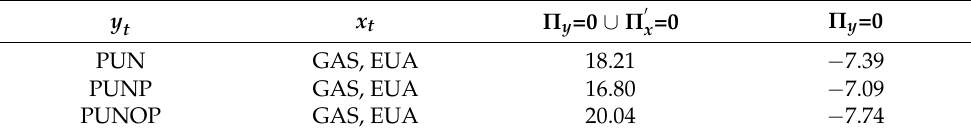
Table A3. Bound test to